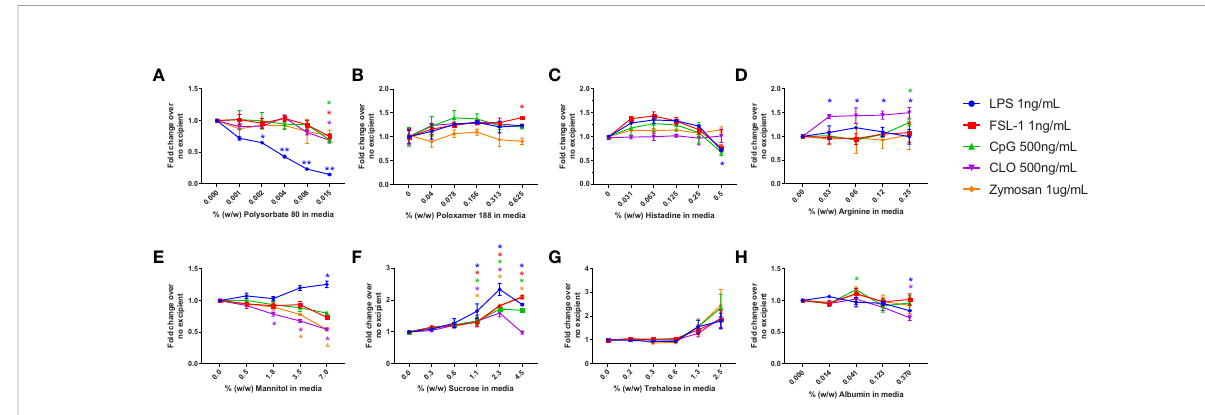
FIGURE 2 Impact of excipients on the sensitivity of RAW-Blue cells to detect IIRMI. RAW-Blue cells were stimulated with a single dose of different model IIRMI in the presence of increasing concentration of (A) Polysorbate 80, (B) Poloxamer 188, (C) Arginine, (D) Histidine, (E) Mannitol, (F) Sucrose, (G) Trehalose, or (H) Albumin for 24 hours. IIRMI activation of RAW-Blue cells was measured as NF- k B activation using Quanti-blue detection media. Graphs show the fold changes relative to the corresponding IIRMI stimulation in the absence of excipients. Cells were treated in triplicate and results are presented as the mean ± SD for 3 independent experiments. *p < 0.05 and **p <